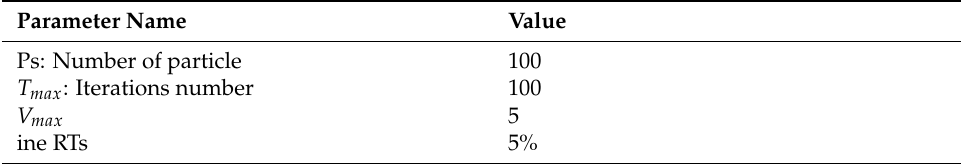
Table 1. Control parameters values of the